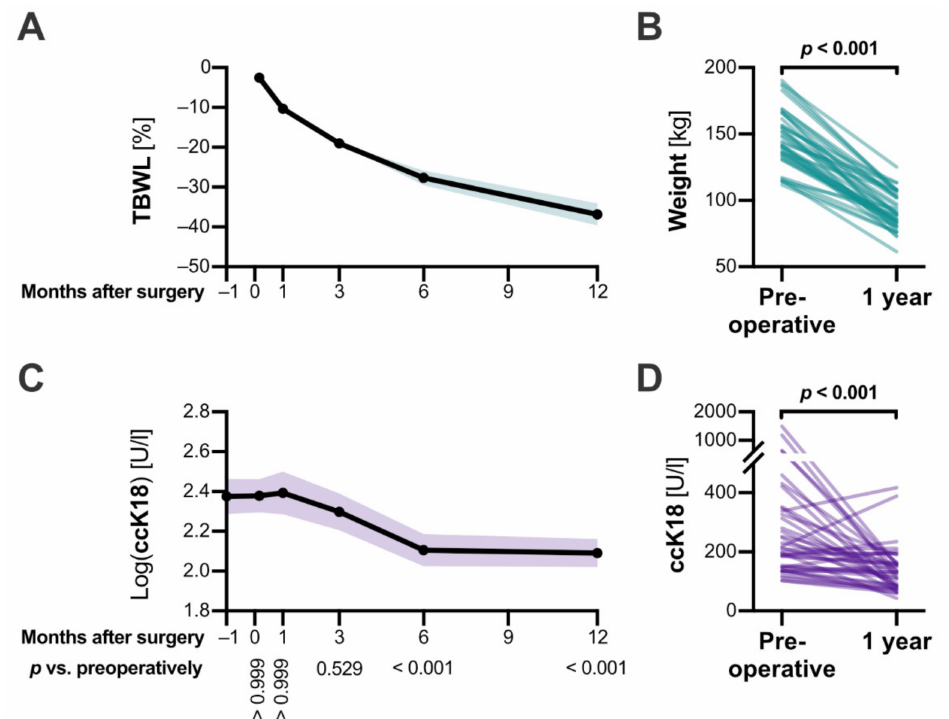
Figure 1. Roux-en-Y gastric bypass led to decreased body weight and caspase-cleaved keratin 18 levels. ( A ) Following the bariatric surgery, patients consistently lost weight with a mean total body weight loss (TBWL) of 37% after one year. Mean (line) and 95% confidence interval (colored area) are shown. ( B ) The reduction in body weight, affecting all included patients, was highly significant 12 months postoperatively when compared to preoperative levels ( p < 0.001). ( C ) Caspase-cleaved keratin 18 (ccK18) fragments were measured utilizing a M30 enzyme-linked immunosorbent assay. Serum levels decreased significantly within 6 months after the procedure. Mean (line) and 95% confidence interval (colored area) are shown. ( D ) The individual course of ccK18 levels was, however, heterogenous among our cohort. A fitted mixed effect model was